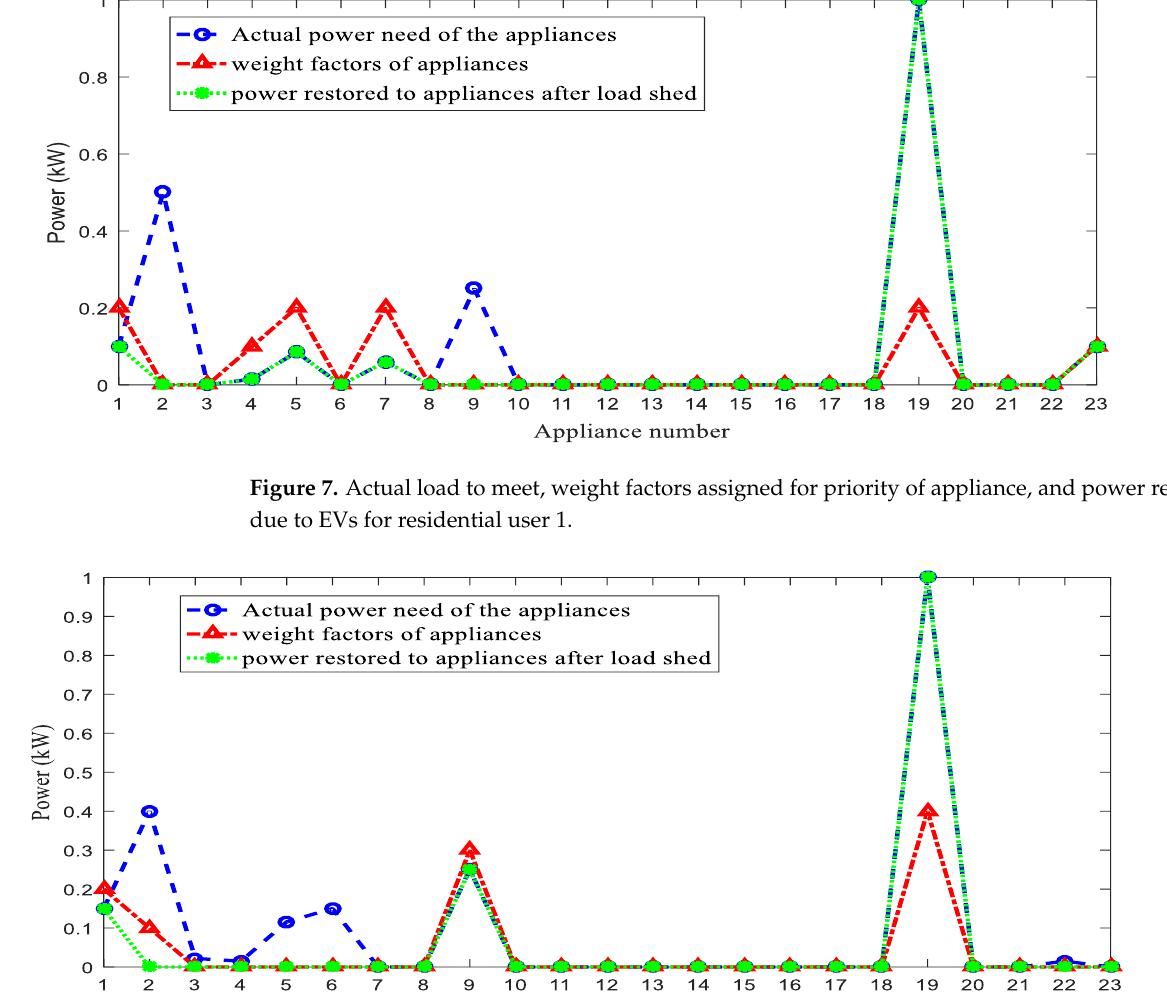
Figure 9. Actual load to meet, weight factors assigned for priority of appliance, and power restored due to EVs for residential user 3. Figure 10. Actual load to meet, weight factors assigned for priority of appliance, and power re- stored due to EVs for residential user 4.